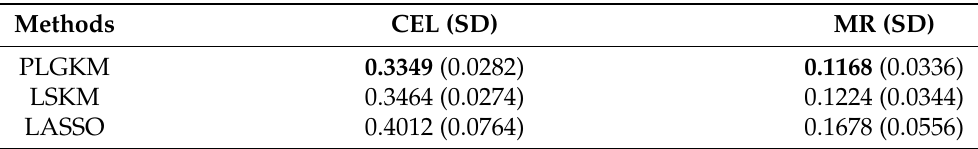
Table 4. Average prediction error of each method for 1000 replications, with their standard deviations in